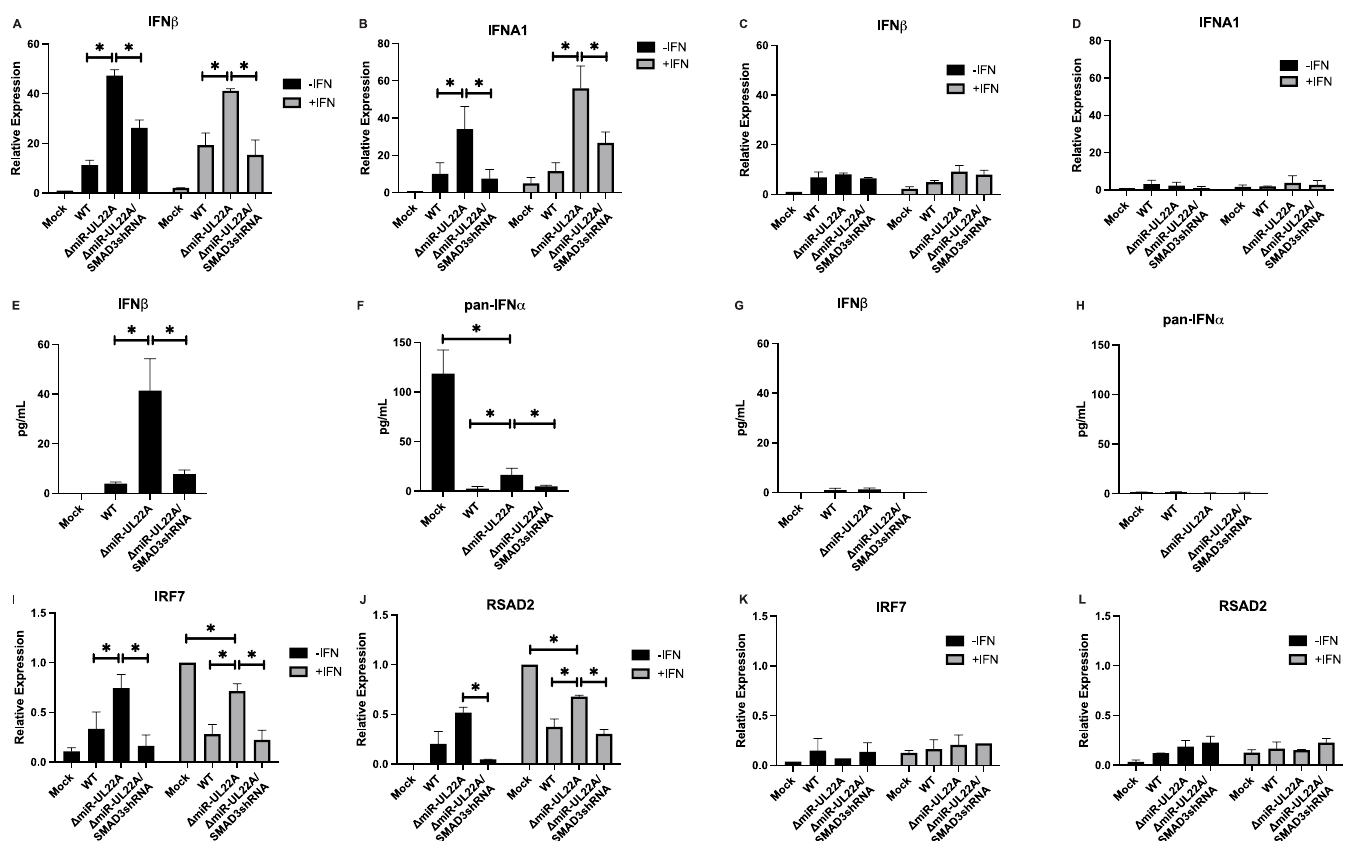
Fig 7. miR-UL22A targeting of SMAD3 regulates IFN and ISG induction in an IRF7-dependent manner. (A-B; tHFs) and (C-D; Δ IRF7 cells) were infected with the indicated viruses for 48 hours followed by treatment with uIFN (1000U/mL) for 16 hours. RNA was isolated and subjected to qRT-PCR for IFN β and IFN α 1. (E-H) tHF and Δ IRF7 cells were infected as in (A) and supernatants were harvested after 72 hours. ELISAs were performed for (E,G) IFN β and (F,H) pan-IFN α . (I-L) tHF and Δ IRF7 cells were infected as in (A) and treated with IFN after 24 hours of infection. RNA was isolated 48 hours post-infection and subjected to qRT-PCR for IRF7 and RSAD2. All experiments were performed in triplicate. � p < 0.05 by two tailed Student’s t